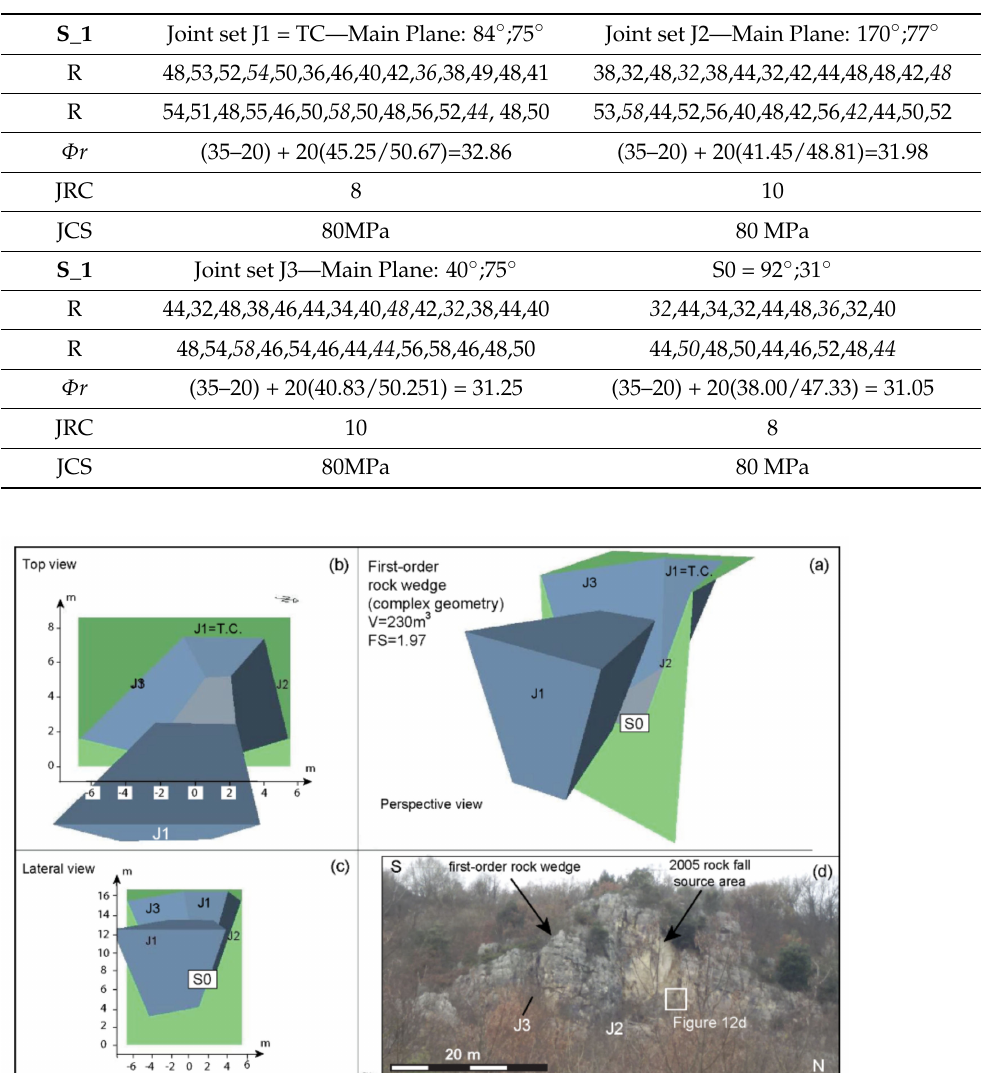
Table 3. Geomechanical analysis for main discontinuities at station S_1. Joint data are in Dip/Dip Direction mode. The extreme bounce values of the Schmidt’s Hammer, discarded from the calculation of r and R, are reported in italics. Legend: TC = Tension Crack; Φ r = residual friction angle; JRC = Joint Roughness Coefficient; JCS = Joint Compressive Strength.